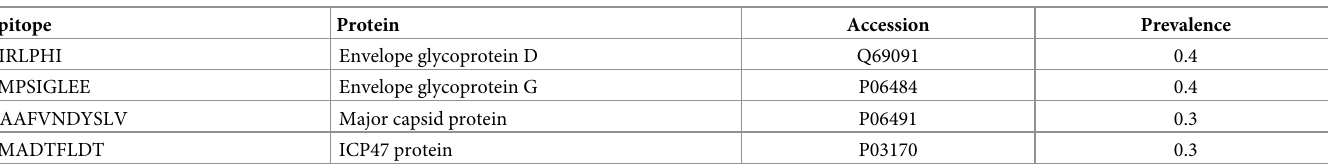
Table 5. HSV1-specific epitopes were